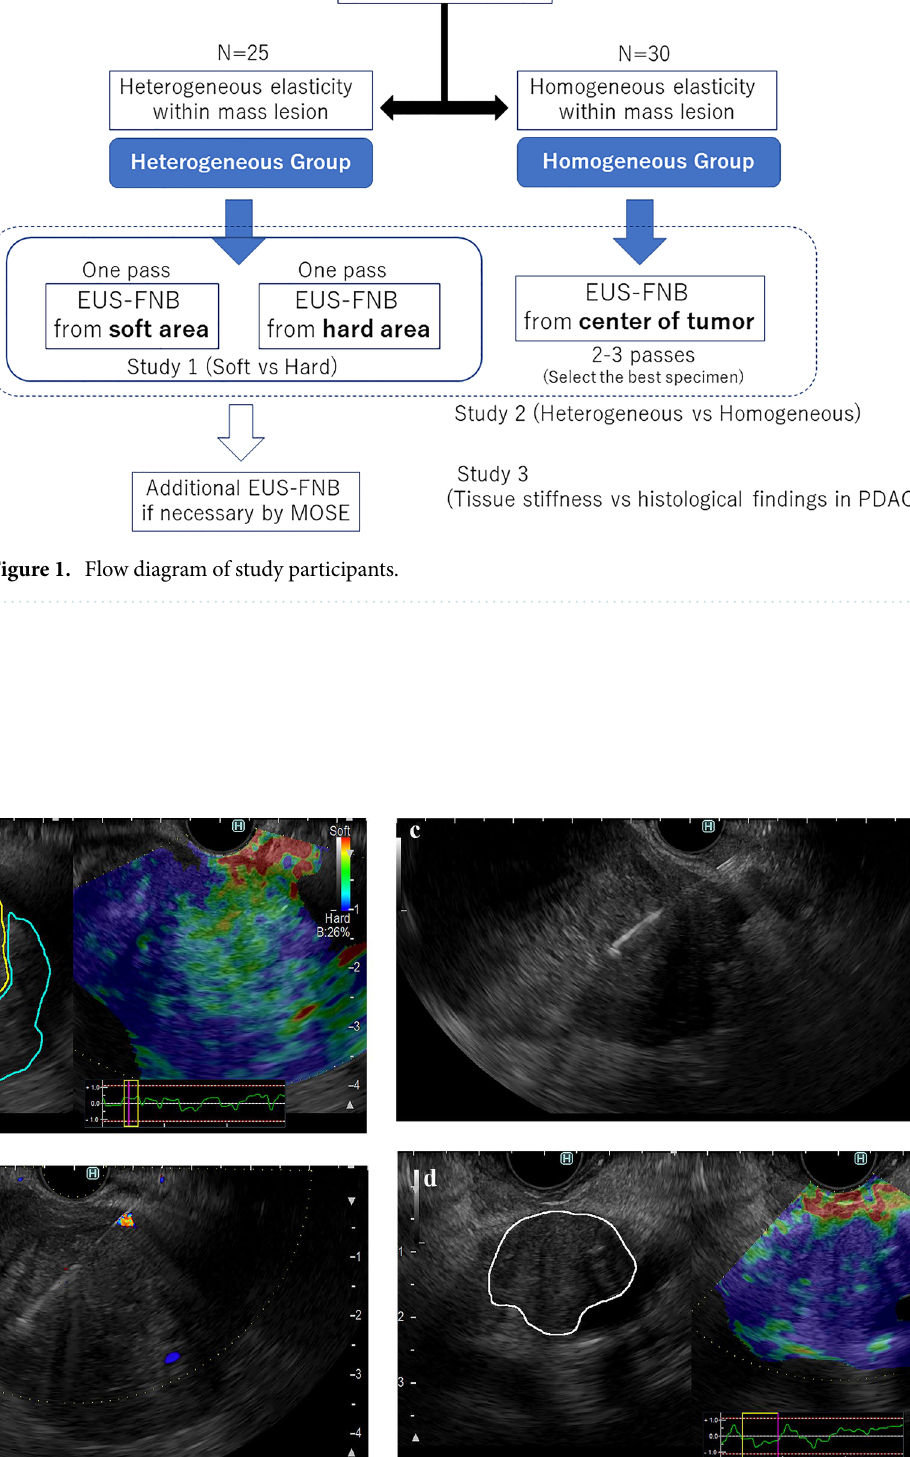
Figure 2. Representative EUS elastography findings of pancreatic solid mass lesions. The yellow surrounding line shows the soft areas, and the blue surrounding line shows the hard areas. In the homogeneous group, the white surrounding line shows the contours of the tumor. ( a ) A patient in the heterogeneous group, with pancreatic ductal adenocarcinoma. The mean strain values in the whole lesion, soft area and hard area were 68.0, 122.2 and 31.4, respectively. ( b ) EUS-FNB to the hard area in the patient shown in Fig. 3a. ( c ) EUS-FNB to the soft area in the patient shown in Fig. 3a. ( d ) A patient in the homogeneous group, with pancreatic ductal adenocarcinoma. The mean strain value in the whole lesion was